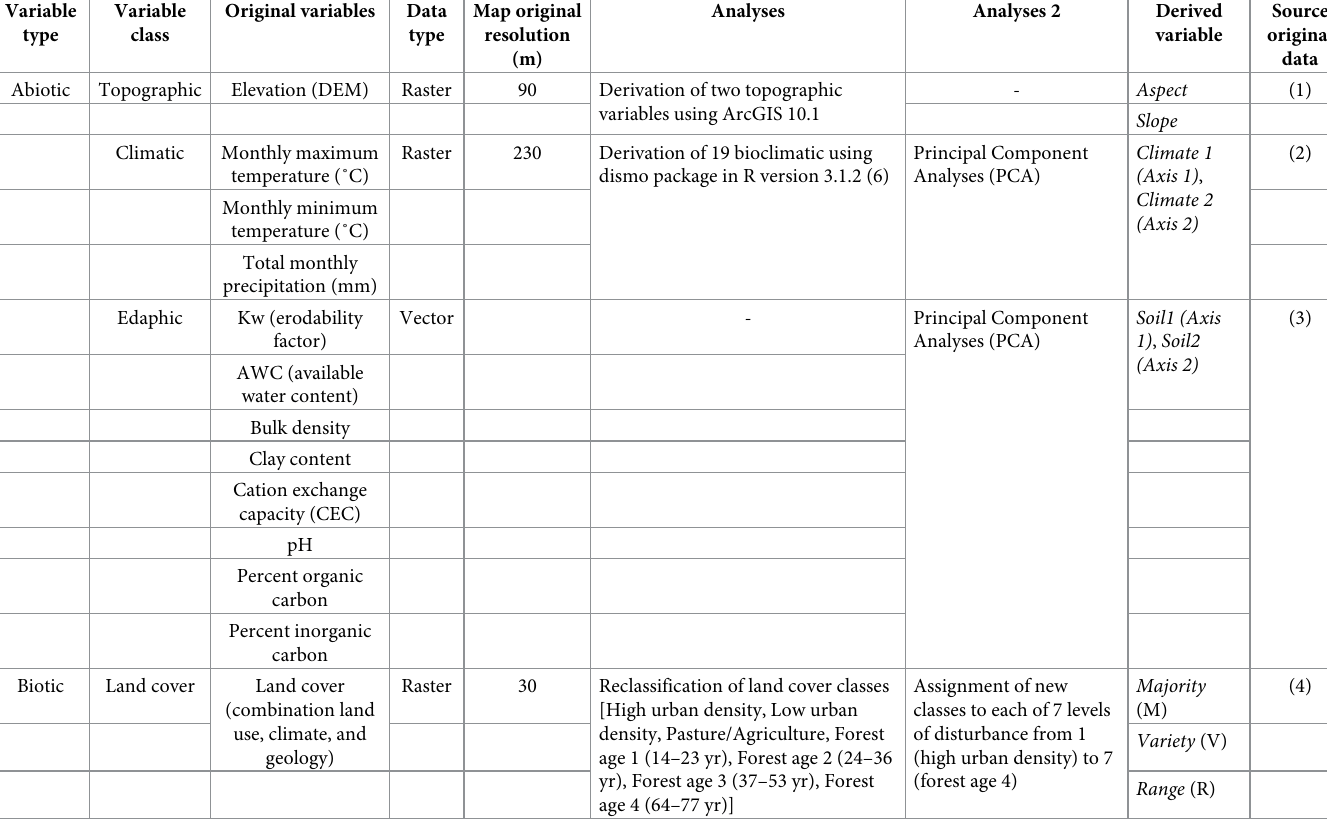
Table 1. Biophysical variables used to characterize the vine patches, including data sources and